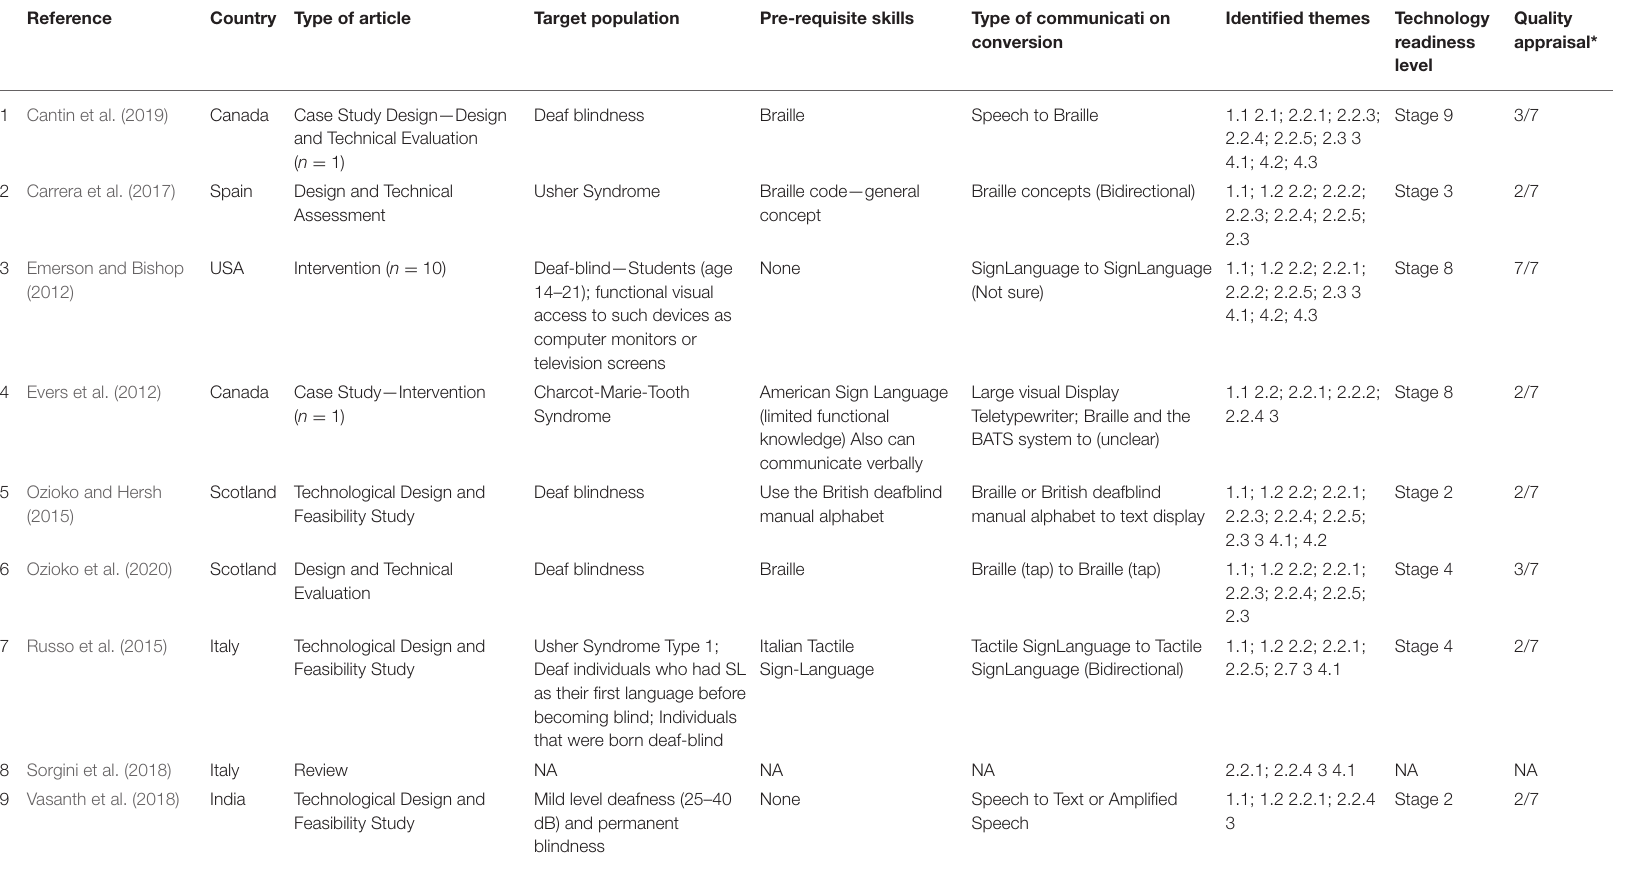
TABLE 2 | Overview of selected